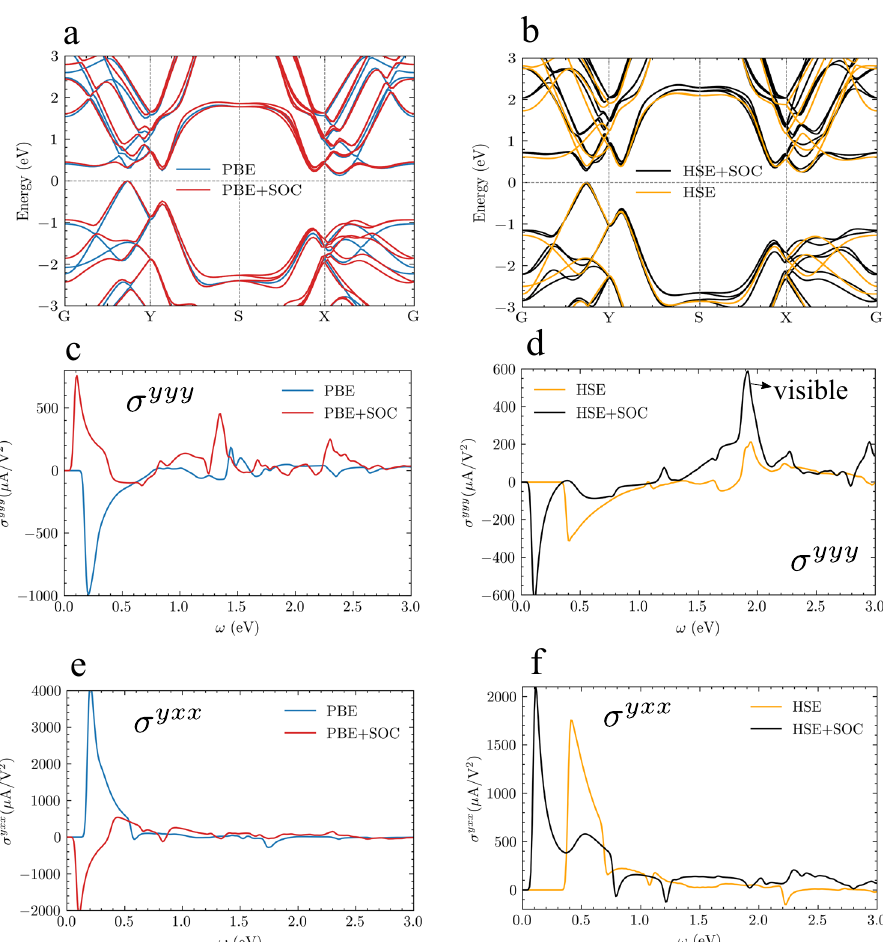
Fig. 5 Electronic band structures and shift current spectra of monolayer Sb. Band structures computed with a PBE and PBE + SOC and b HSE and HSE + SOC. σ yyy spectra computed with c PBE and PBE + SOC and d HSE and HSE + SOC. σ yxx spectra computed with e PBE and PBE + SOC and f HSE and HSE +